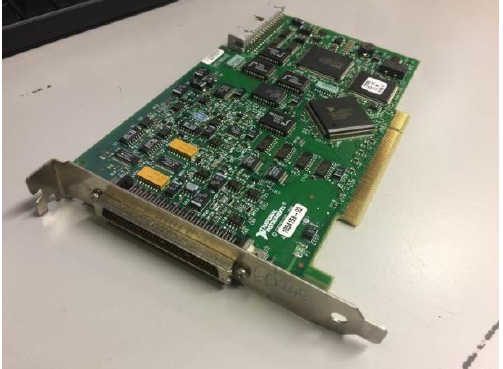
Figure 16. Photo of the used input –output board PCI 6024Е .